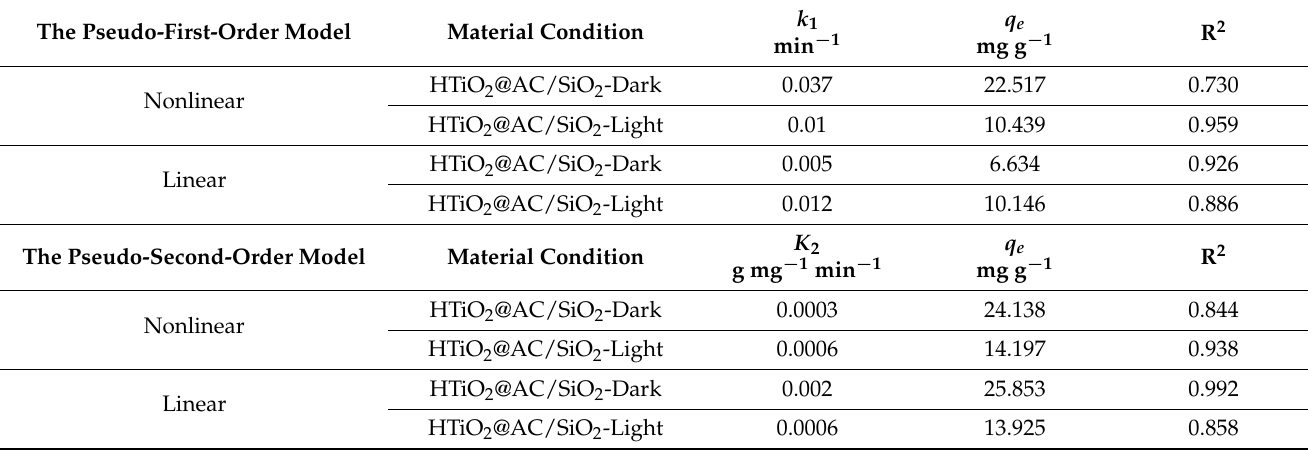
Table 2. Biosorption